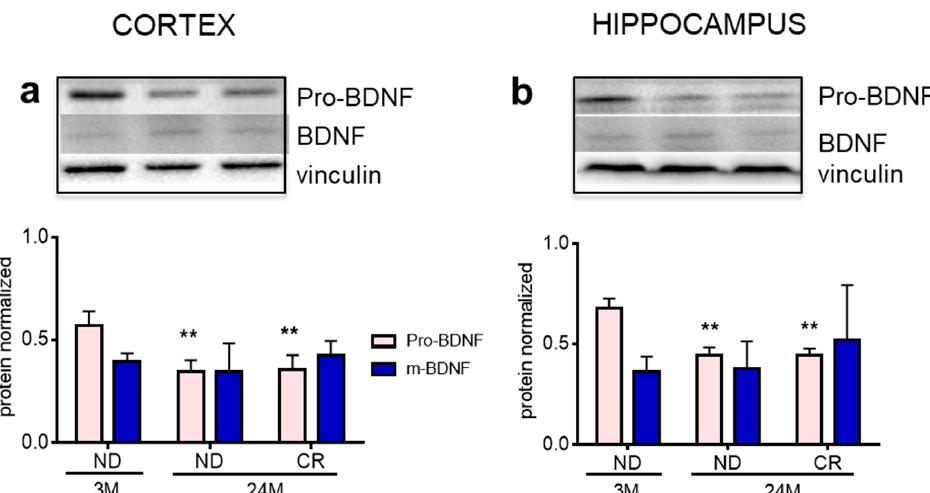
Figure 7. Impact of age and CR on levels of brain-derived neurotrophic factor (BDNF) and pro-BDNF in rat cortex and hippocampus. Representative Western blots and densitometric analyses of pro-BDNF and BDNF in the cortex ( a ) and hippocampus ( b ) normalized to vinculin. 3M (3-month-old rats); 24M (24-month-old rats); ND (normal diet); CR (caloric intake reduced by 40% for the last 6 months of life). Statistical analysis was performed by using one-way ANOVA followed by Tukey’s post hoc test. ** = p < 0.01 vs. ND3M.